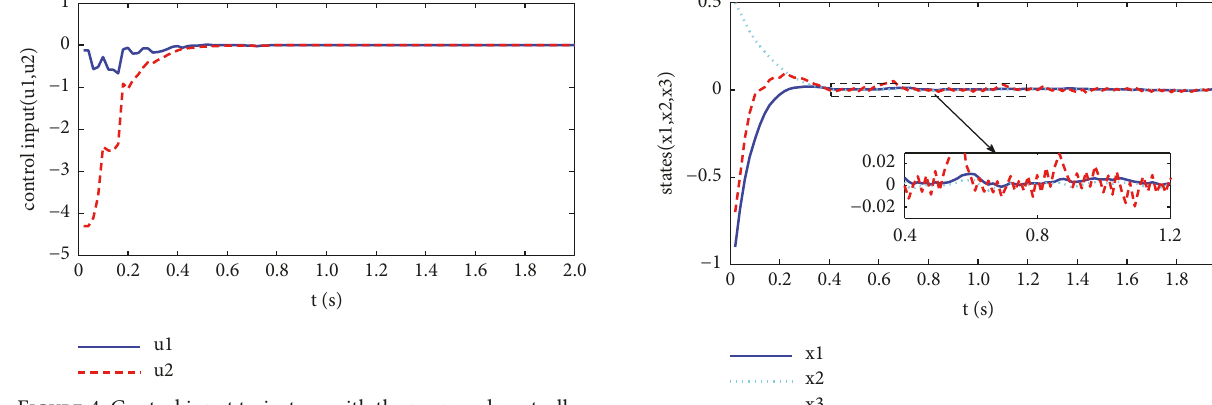
Figure 4: Control input trajectory with the proposed controller.